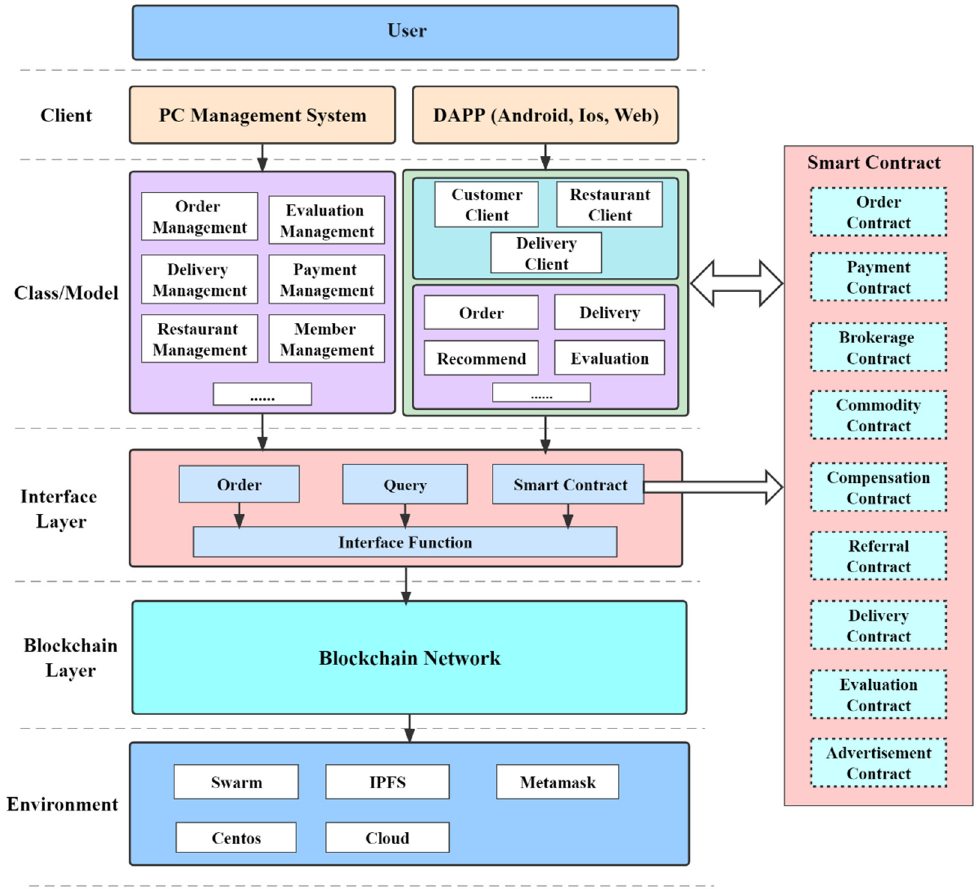
Figure 16. Application layer functional architecture diagram.